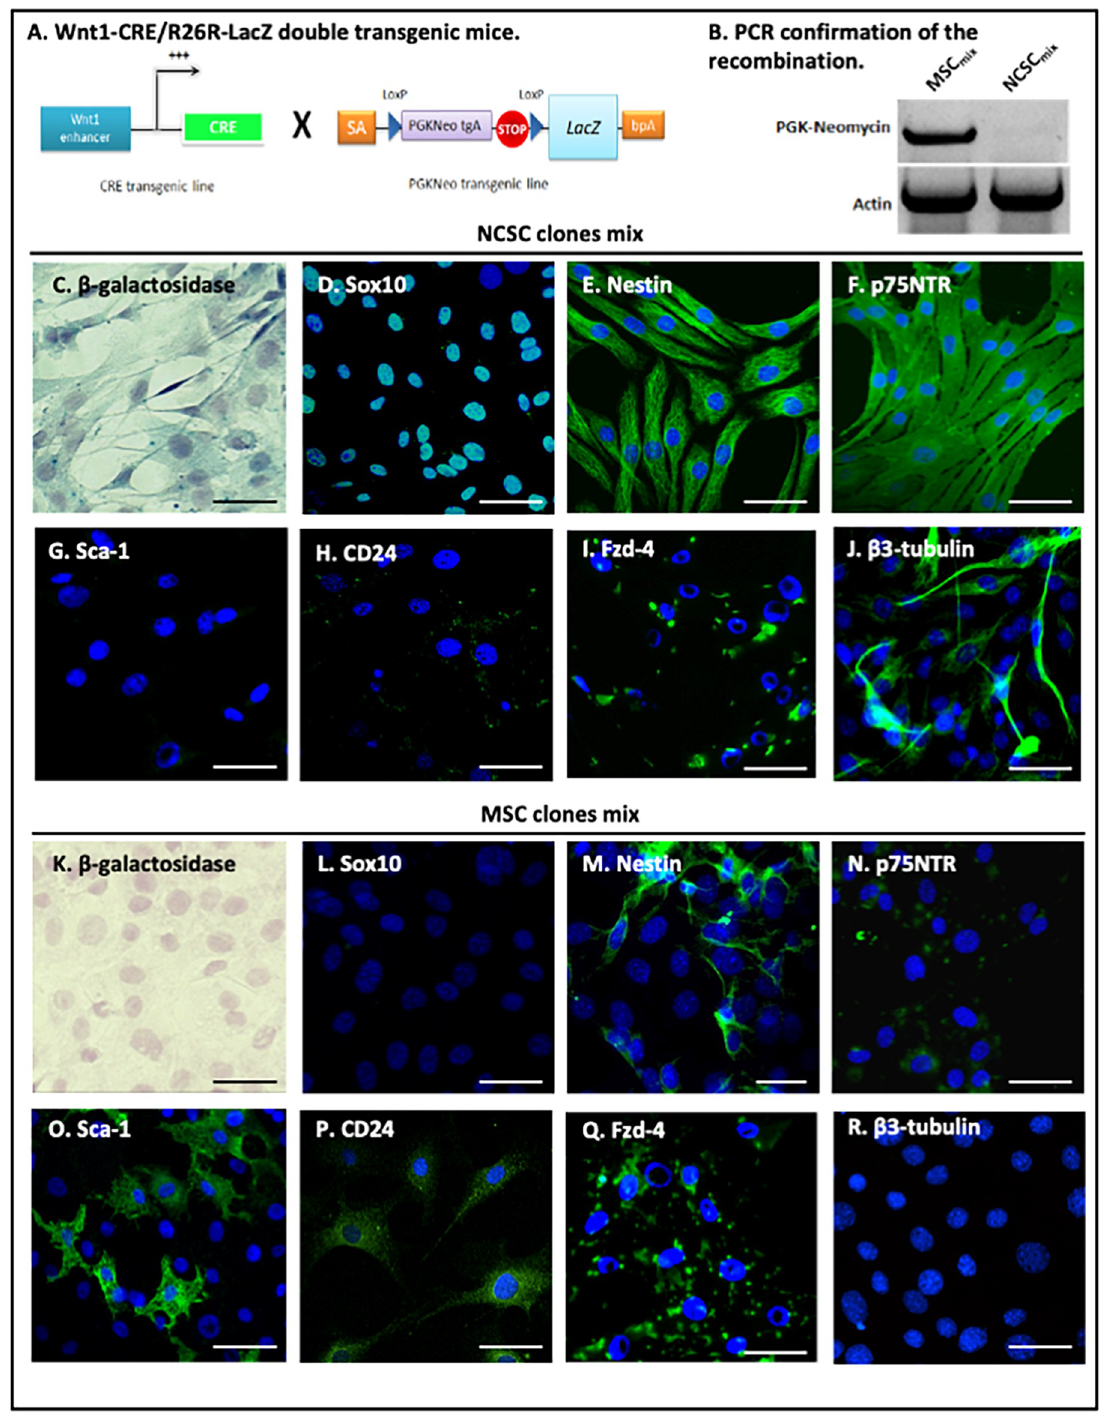
Fig 1. In vitro characterization of NCSCmix and MSCmix, isolated from adult Wnt1-Cre/R26R-LacZ mouse bone marrow. BMSC were harvested from double-transgenic Wnt1-CRE/R26R-LacZ mouse bone marrow (A). Amplification of the PGK-Neo cassette confirmed that NCSC mix underwent recombination, conversely to MSC mix (B). NCSC mix were β -galactosidase positive ( blue , C), whereas MSC mix were not ( blue , K) (Hematoxylin–stained nuclei). NCSC mix expressed neural crest-associated proteins Sox10 ( green , D), Nestin ( green , E) and p75NTR ( green , F). MSC mix were Sox10-negative ( green , L), weakly p75NTR-positive ( green , N), and only a small proportion ( < 15%) of cells expressed nestin ( green , M). MSC mix also expressed Sca-1 ( green , O) and CD24 ( green , P) while NCSC mix did